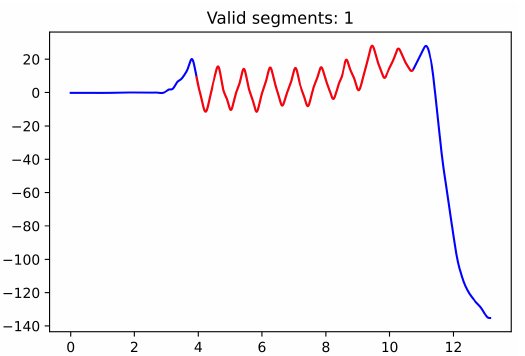
Figure 2. A participant in the HC group (usual walk); in blue, all values; in red, the walking phase during one